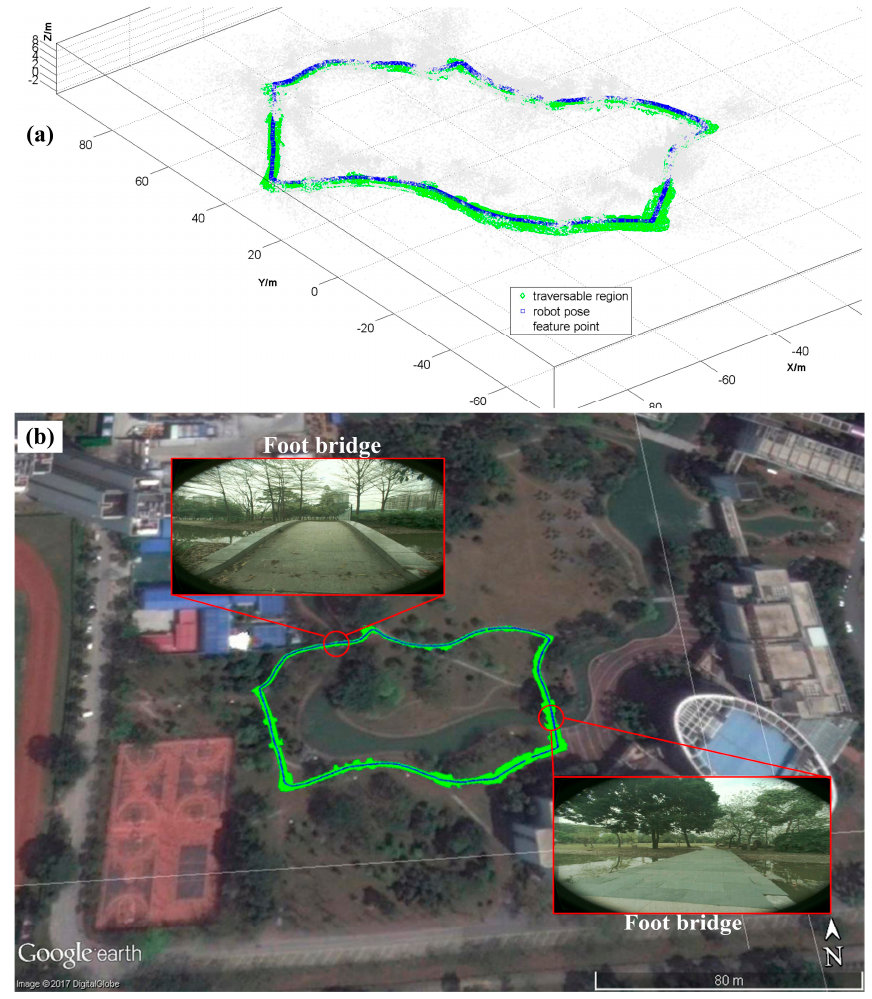
Figure 11. A complete loop trajectory of the robot with traversable regions ( a ) blue: robot pose, green: traversable region, grey: feature point; ( b ) traversable mapping overlapped on real map.